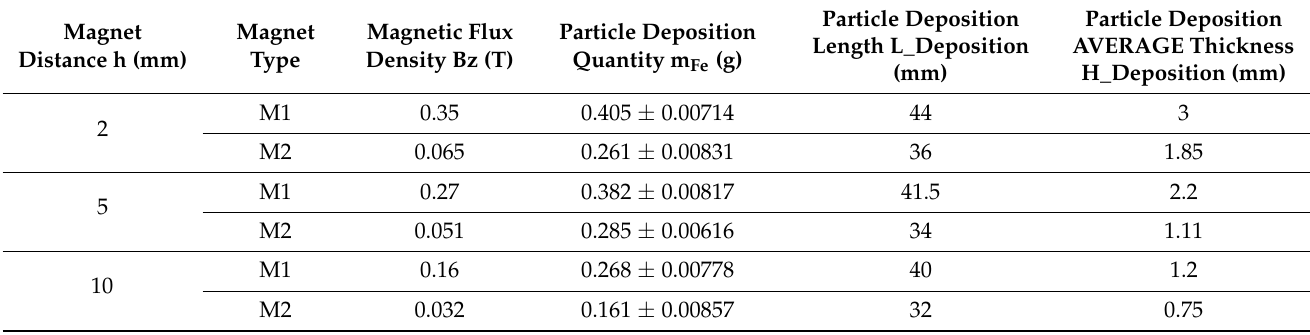
Table 10. Characteristics of the particle accumulation shape along the artery lower wall at the end of the injection